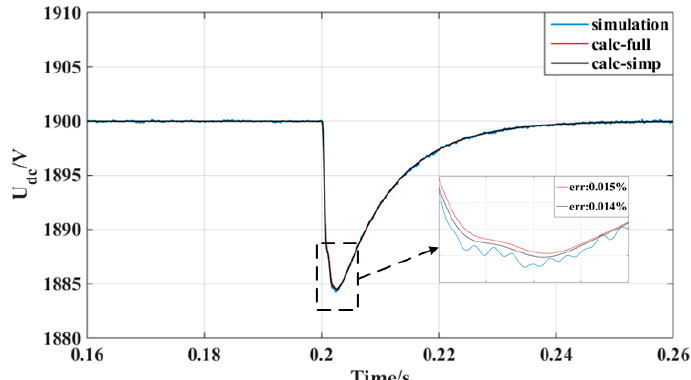
Figure 5. The waveform of input dc bus voltage (load step).